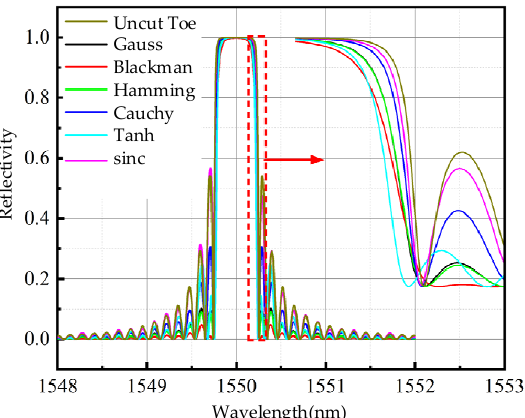
Figure 7. Grating reflection spectra after different toe cutting methods.